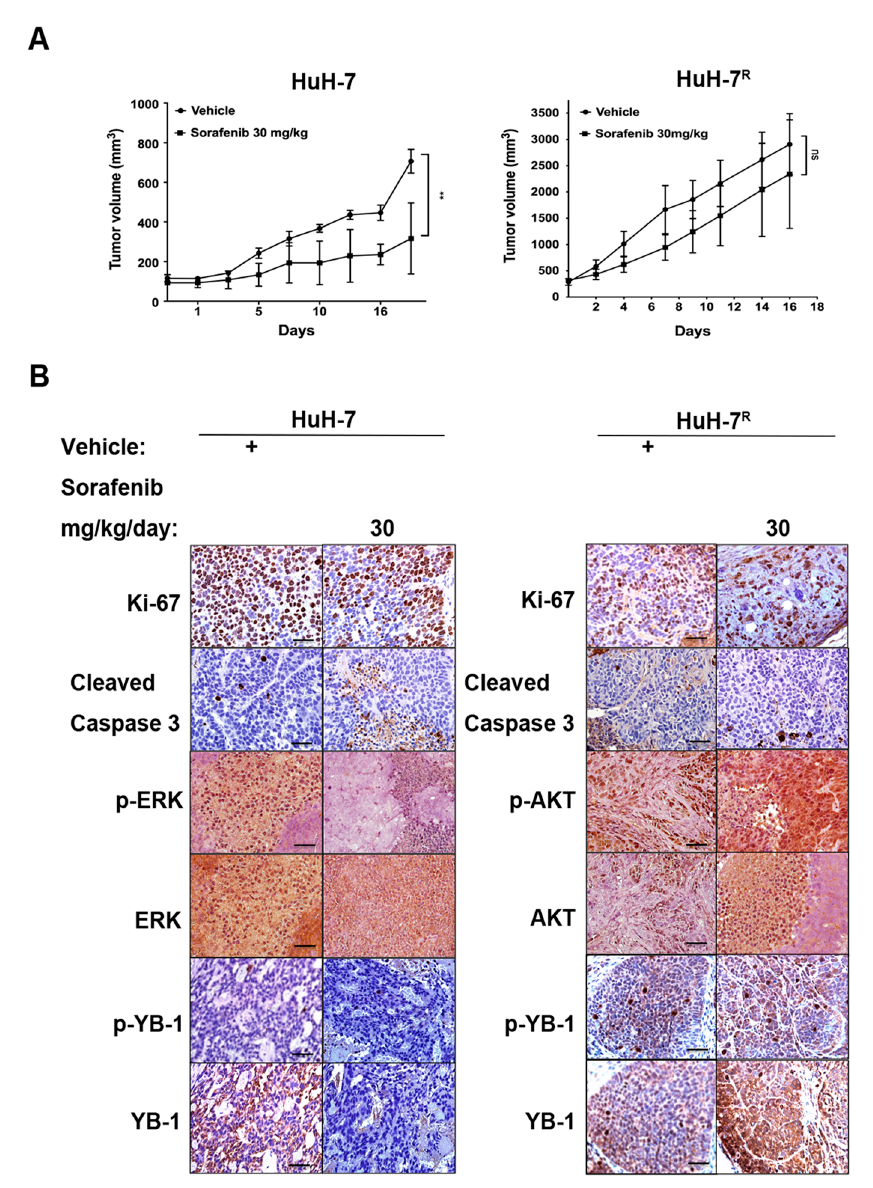
Figure 3. Effects of sorafenib on tumor growth and differentially expressed proteins of HuH-7 and HuH-7 R cells in xenograft models. ( A ) In vivo effects of sorafenib on tumor growth of HuH-7 or HuH-7 R mice. Nude mice were injected subcutaneously with HuH-7 or HuH-7 R cells. Mice were orally administered vehicle or sorafenib 30 mg/kg for 18 days. Tumor volumes at the indicated time-points were calculated and plotted ( n = 5/group). p Values were determined using the t test. (ns, not significant; ** p < 0.01). ( B ) Changes in specific protein markers in HuH-7 and HuH-7 R tumors tissues. Paraffin-embedded sections of tumor tissues were analyzed via immunohistochemistry and stained with the indicated antibodies. Representative sections were captured at 400 ×